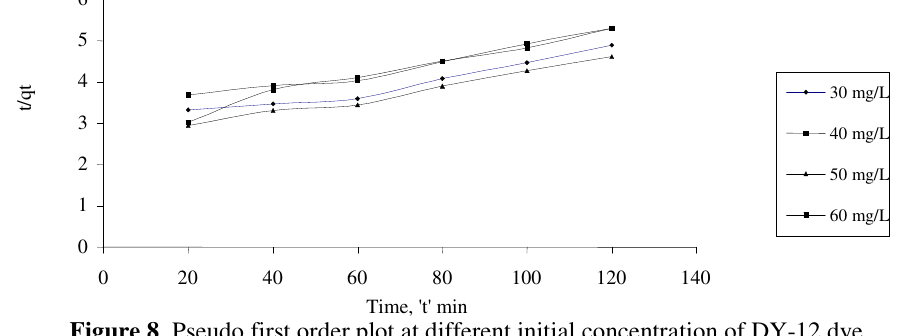
Figure 8 . Pseudo first order plot at different initial concentration of DY-12 dye